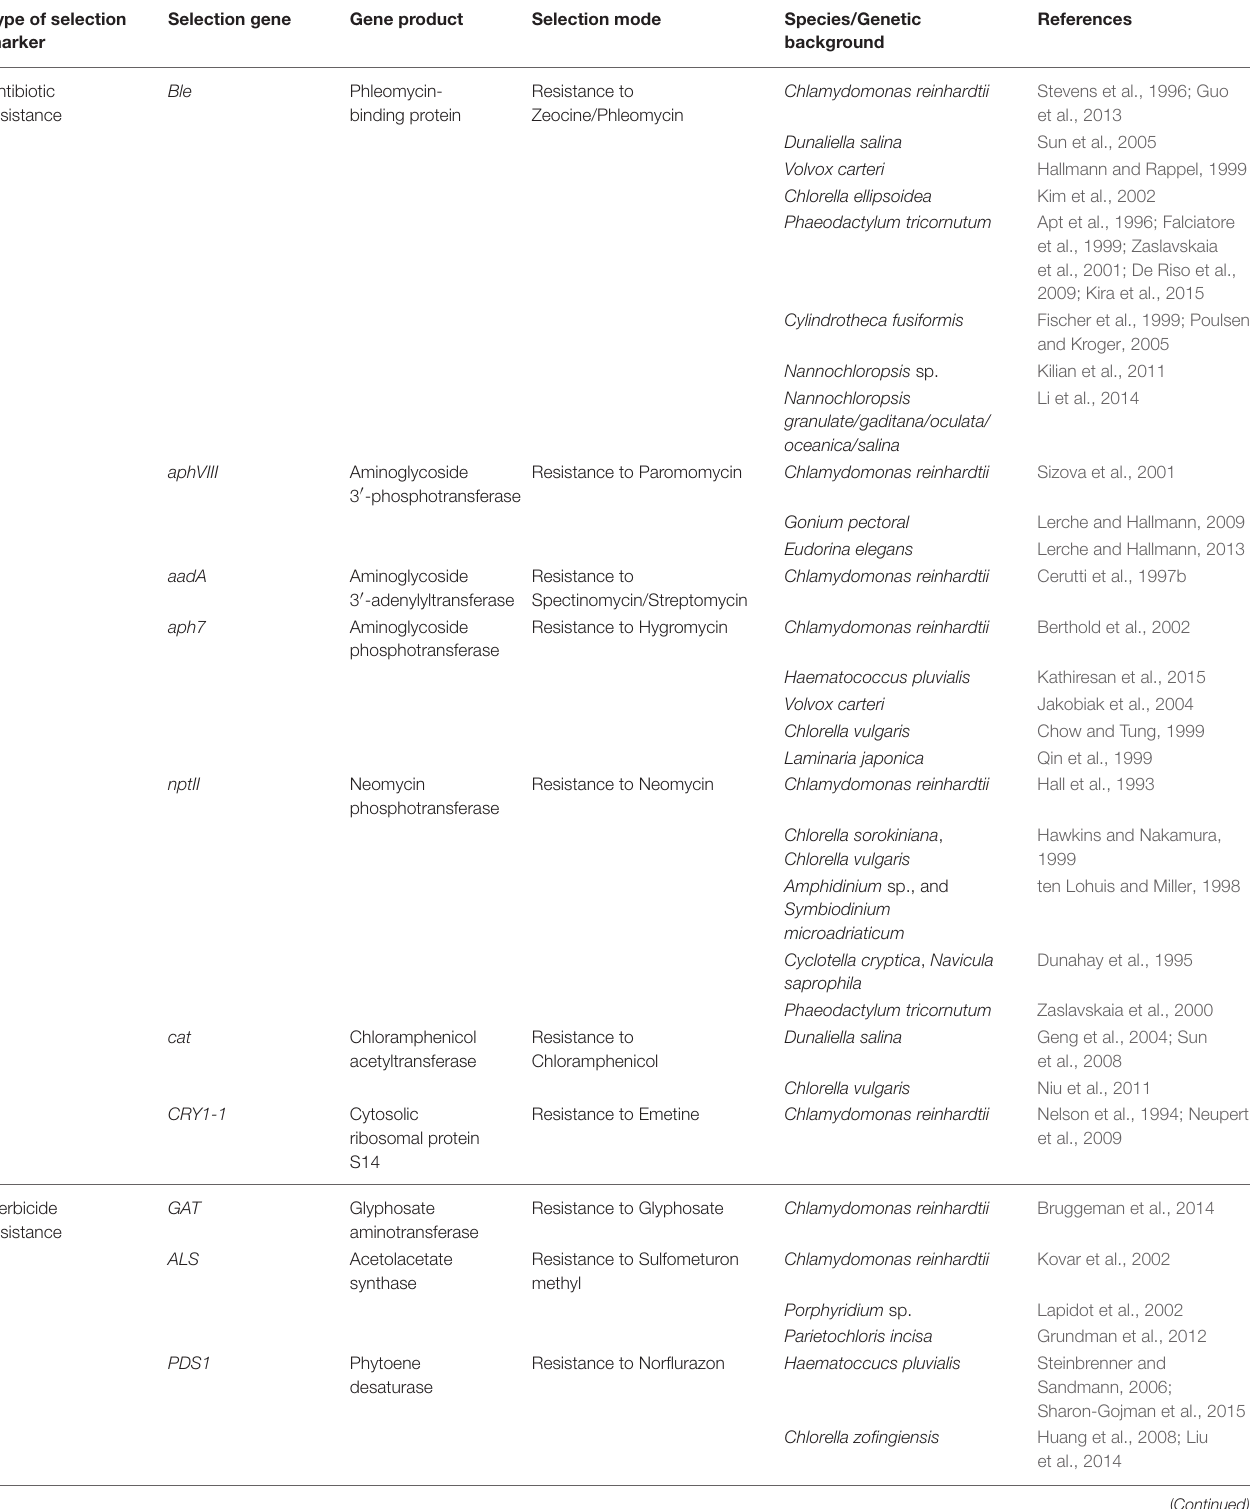
TABLE 3 | List of selection markers and selection modes for nuclear transformation. Type of selection